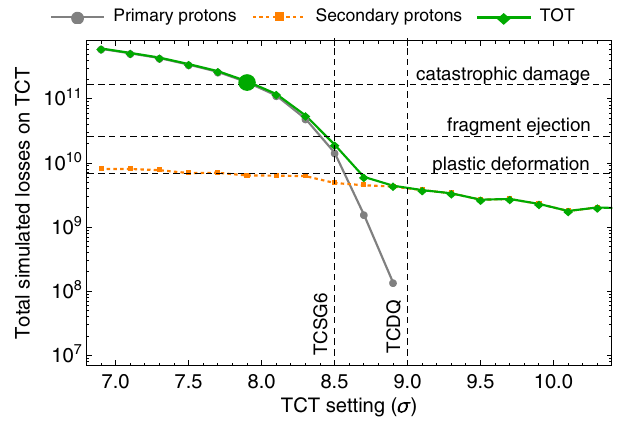
FIG. 20. Simulated losses expected at the TCT compared with the estimates of damage for Case 3. The contribution of primary and secondary protons is shown in grey. The losses are estimated for a bunch population of 2 . 2 × 10 11 p = b.